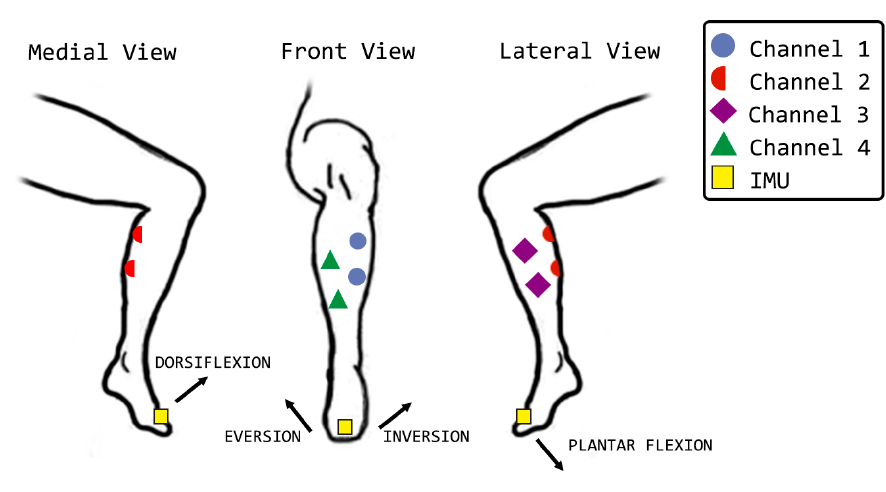
Figure 5. Setup test. Electrodes and IMU positing in medial, frontal, and lateral views. The figure shows electrodes of each channel positioning and indicates the direction of